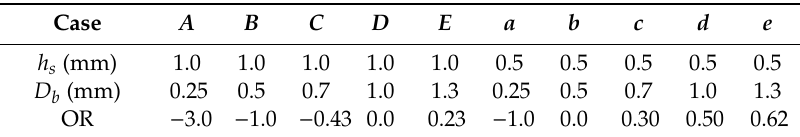
Table 1. Process